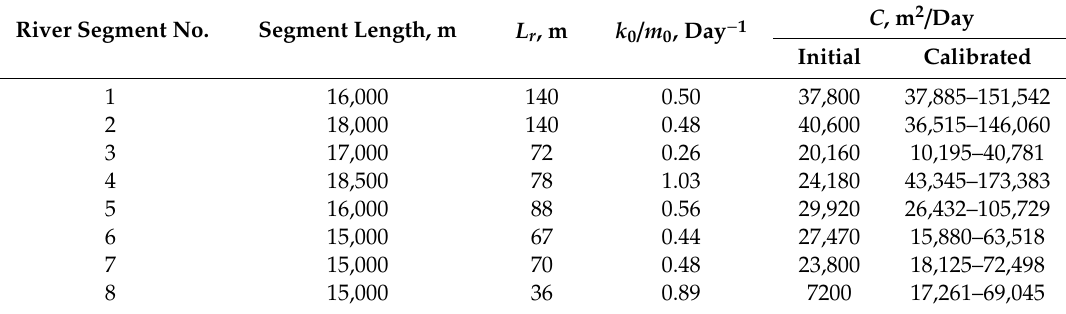
Table 2. River width ( L r ), riverbed k 0 / m 0 , and riverbed hydraulic conductance ( C ) of the river segments. River Segment